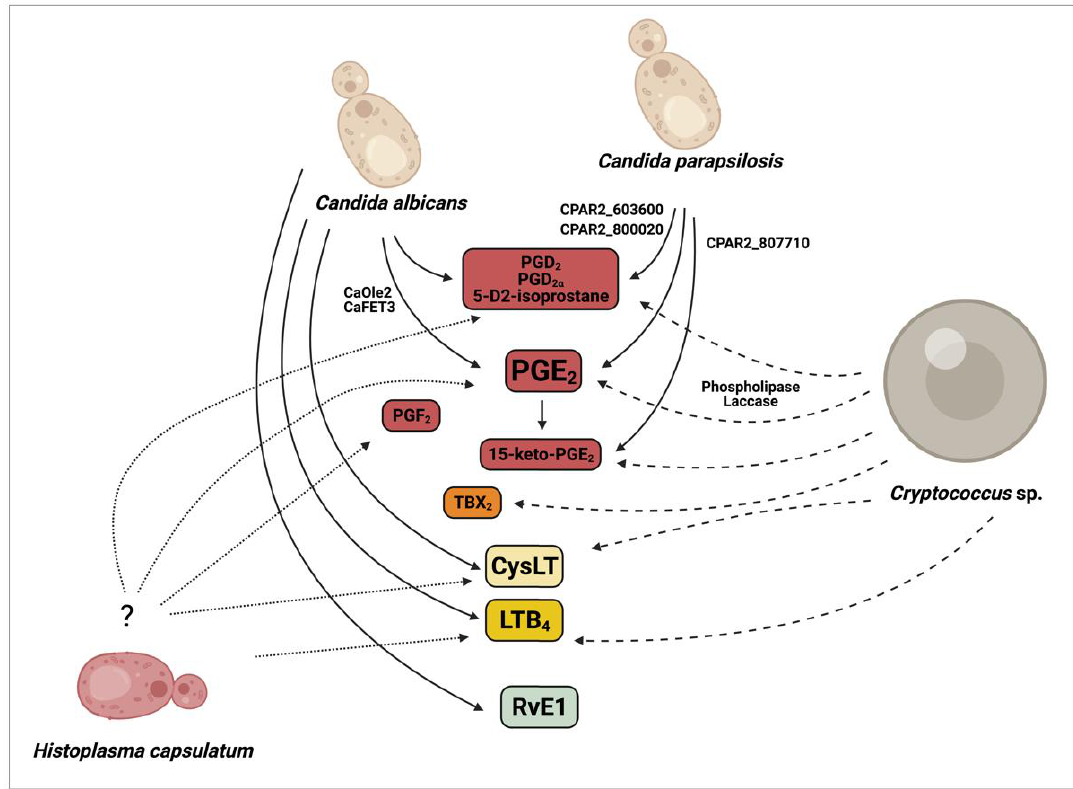
Figure 2. Eicosanoids production in Candida sp., Cryptococcus sp. and Histoplasma capsulatum . The figure illustrates genes involved in the synthesis of eicosanoids, with exception of H. capsulatum , with as yet undescribed genes involved. Lines and arrows indicate the eicosanoids produced by Candida sp. (solid lines), Cryptococcus sp. (dashed lines) and H. capsulatum (dotted lines).